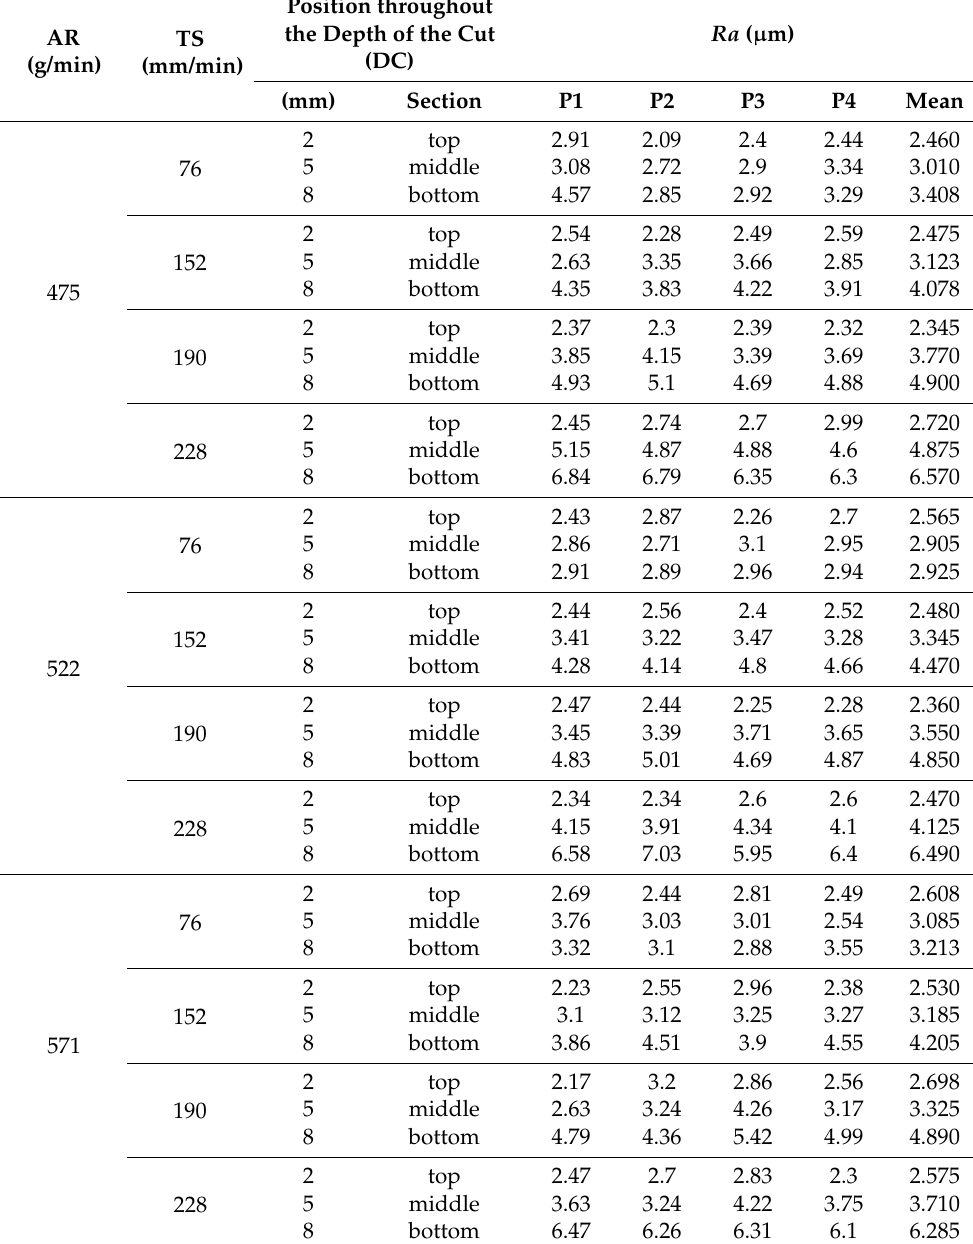
Table 4. Ra values in the machining of the workpiece with 10 mm